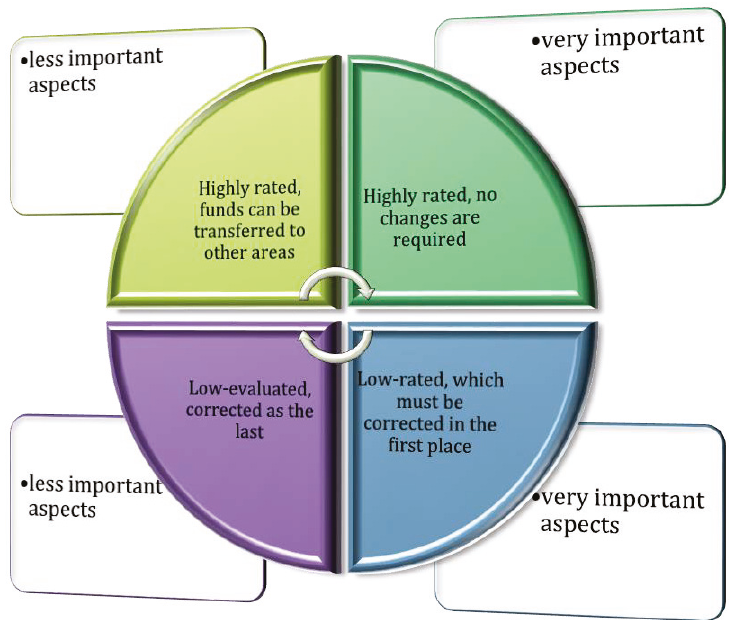
Figure 1. Quality map of the change process.